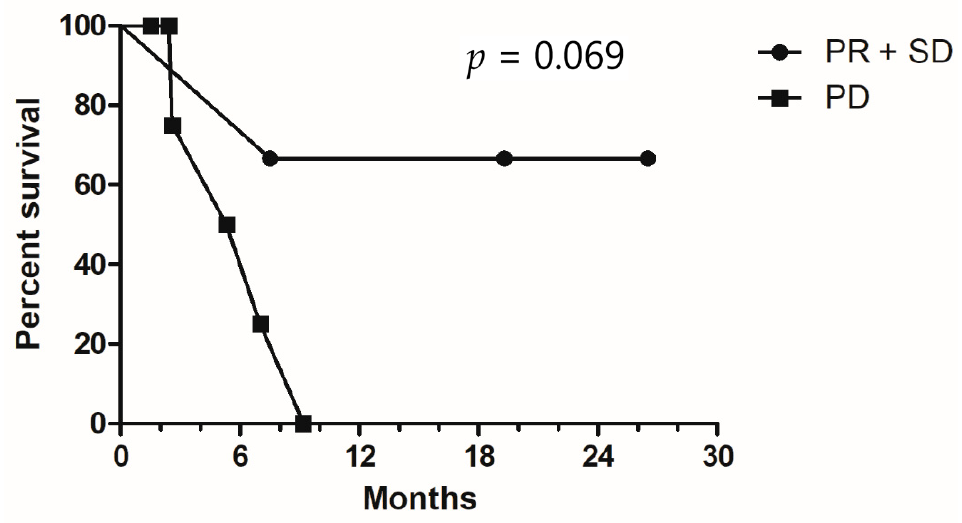
Figure 2. Kaplan–Meier survival curves for overall survival, stratified by disease control status. PR, partial response; SD, stable disease; PD, progressive disease.